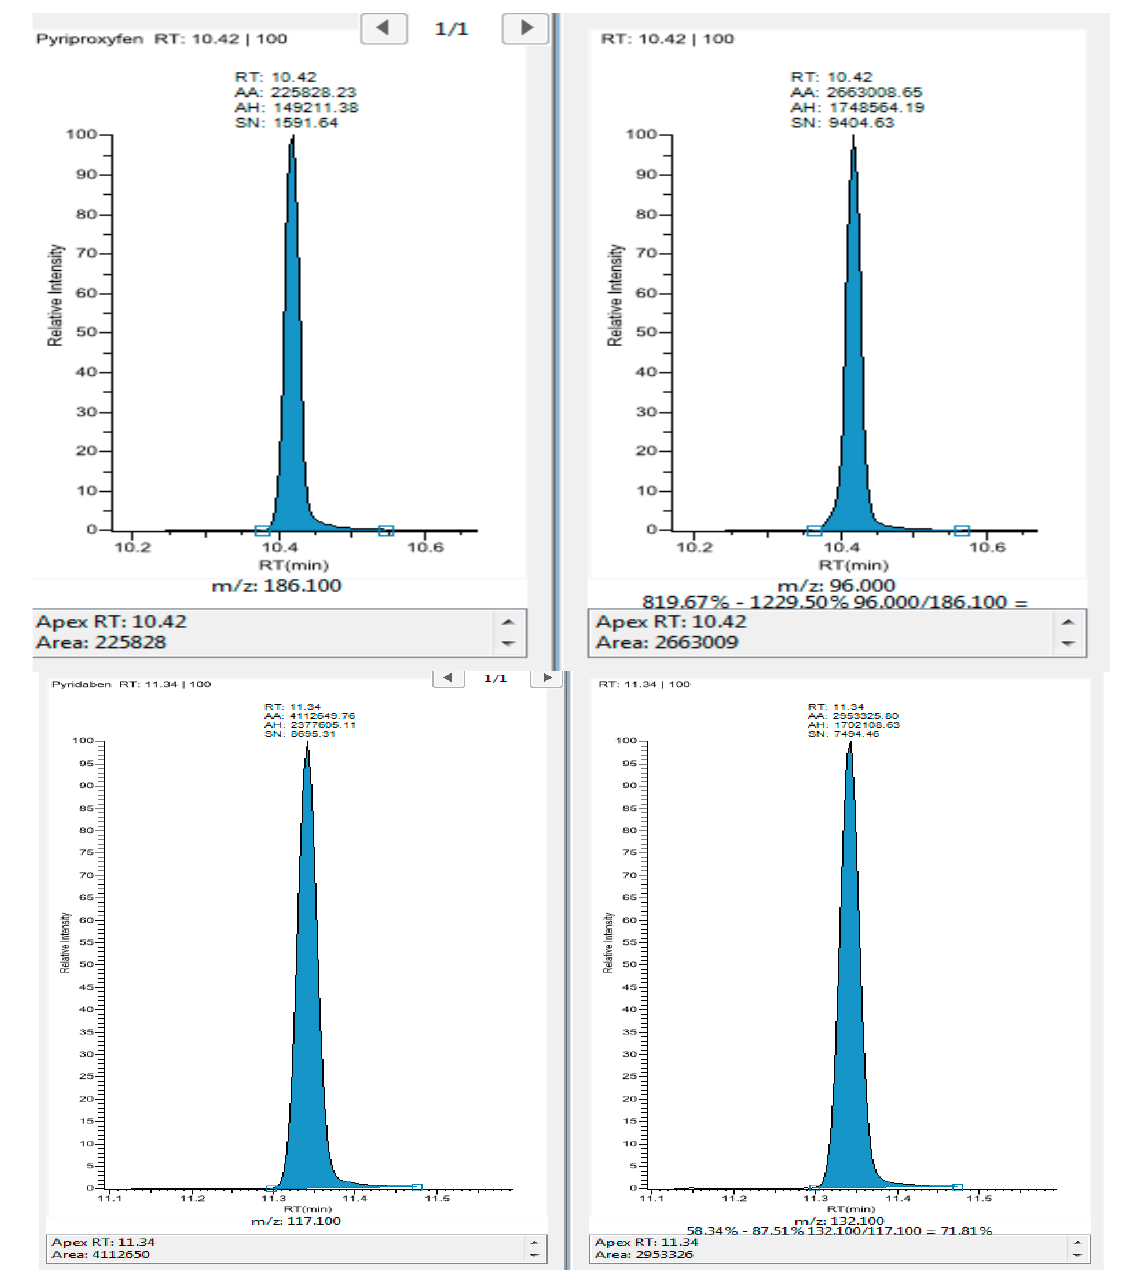
Figure 9. Representative multi-reaction monitoring SRM chromatograms for (1) Pyriprofexen and Pyridaben, spiked at a level of 0.100 µg/g in tomato and extracted using the sample preparation protocol reported (GC MSMS peaks).